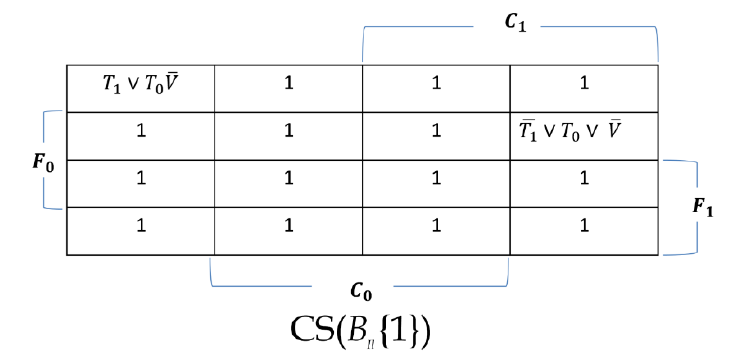
{ }. . Negated and contradictory are 𝑰𝒍